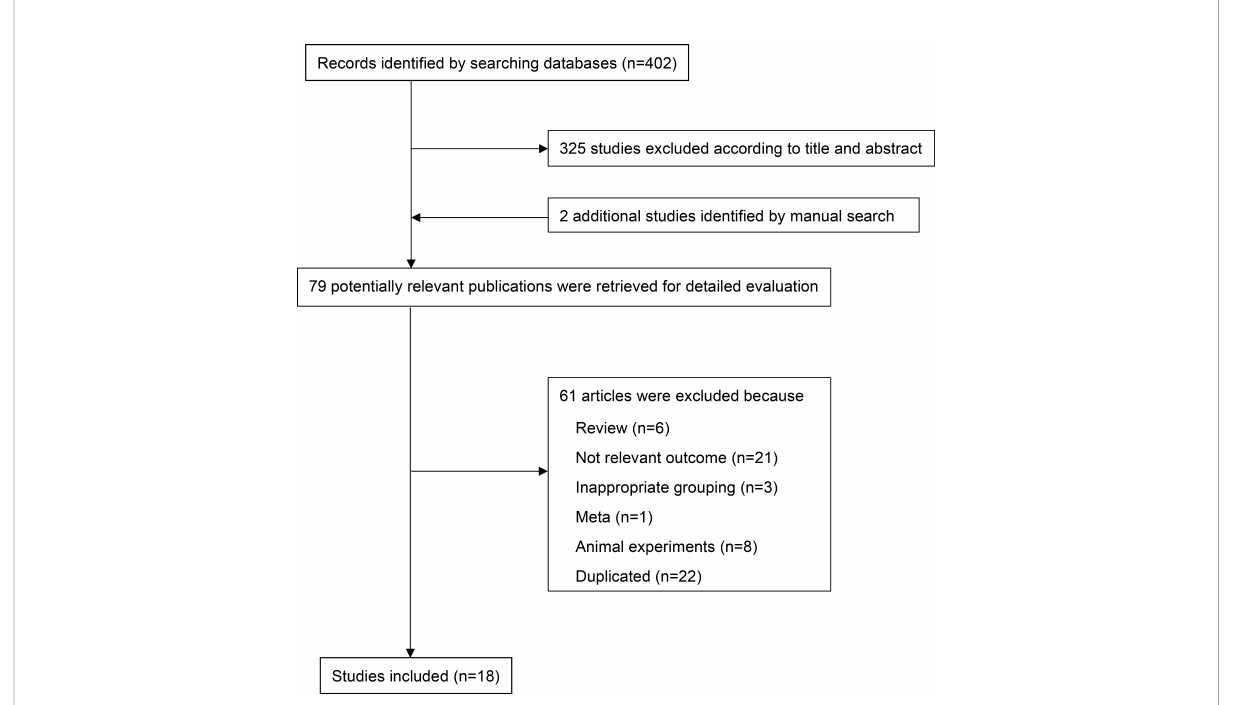
FIGURE 1 Flowchart for the search and selection of research. randomized controlled